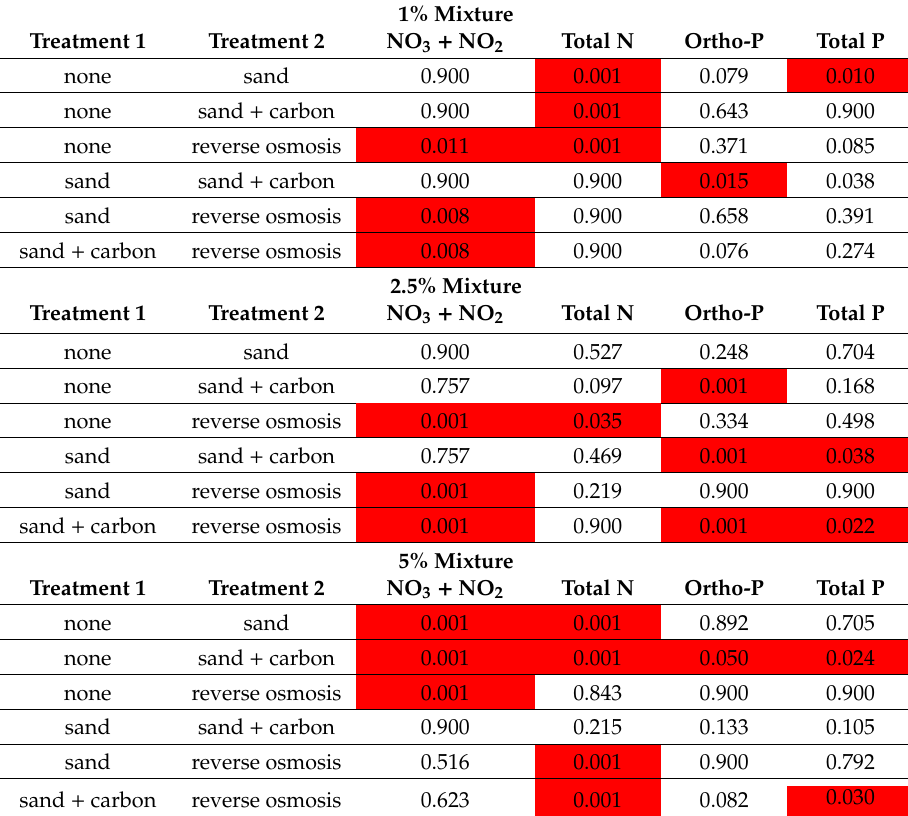
Table 10. Significant di ff erences between methods for each form of nitrogen and phosphorus after nitrification were calculated using the Tukey HSD method, and the p -values are presented for each treatment comparison. Significant di ff erences ( p < 0.05) are highlighted in red for